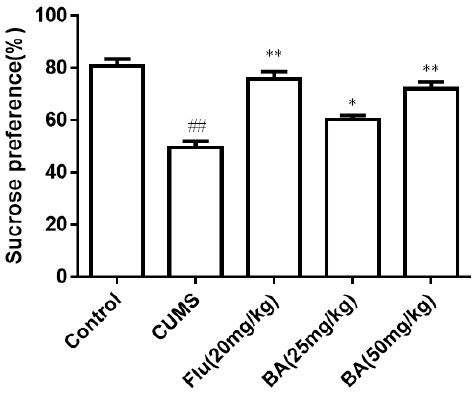
Figure 1. Effects of baicalin (BA) on Sucrose consumption. Data were expressed as mean ± SEM ( n = 12). ## p < 0.01 vs. the control; ** p < 0.01, * p < 0.05 vs. the CUMS group.